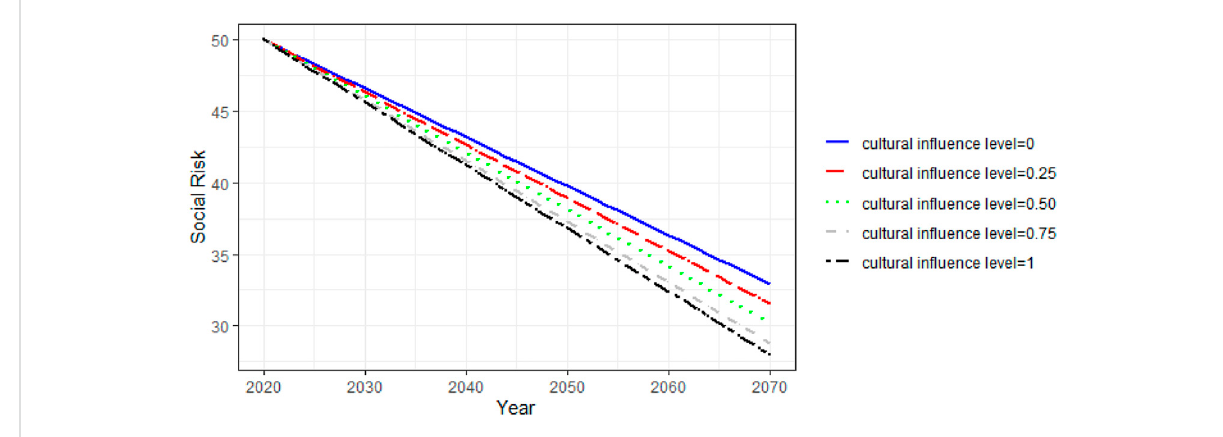
FIGURE 3 Cultural in fl uence level sensitivity